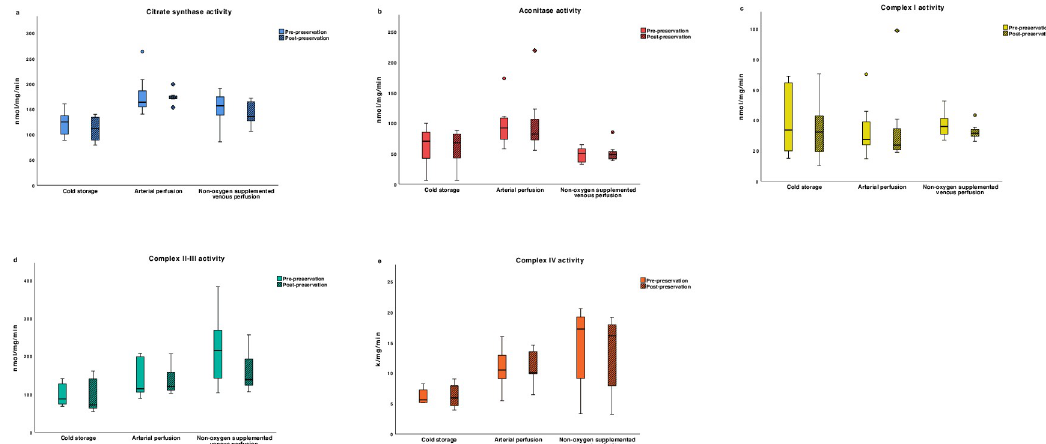
Fig 2. Box whisker plots of mitochondrial enzyme activities in stage 1. The plots demonstrate the distribution of enzyme activities round the median in each group, shown before and after 4-hr end-ischaemic hypothermic machine perfusion and 4-hr static cold storage. The change in enzyme activities was not significantly different between groups (p > 0.05). Top and bottom whiskers represent the maximum and minimum values, respectively. Circles represent outliers (1.5 to 3x interquartile range) and diamonds represent extreme outliers ( > 3x interquartile range).